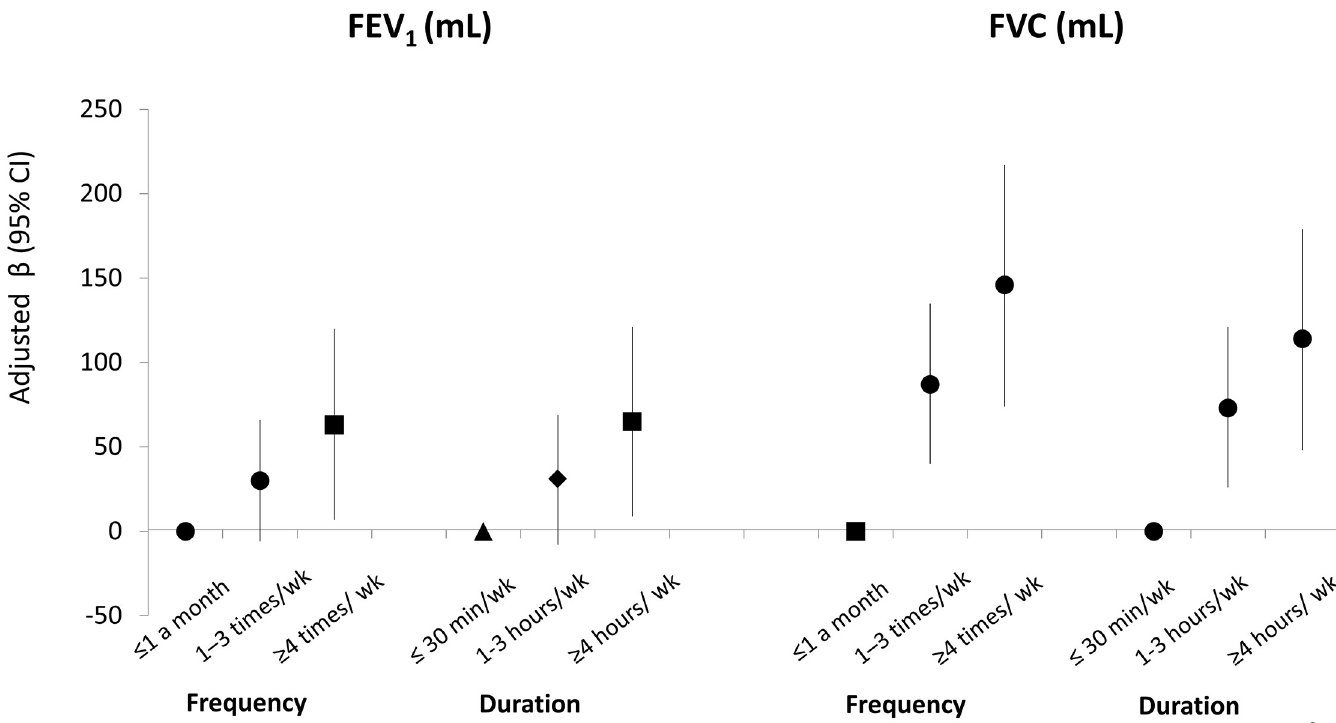
Fig 4. Effects of frequency and duration of physical activity on lung function, estimated using MSMs in the ECRHS cohort. β : difference in the expected lung function measure. � Models included number of pack-years smoked, passive smoking exposure, weight, sex, education, age, age-squared, height, occupation, AHEI-2010 score, respiratory infection in childhood), and